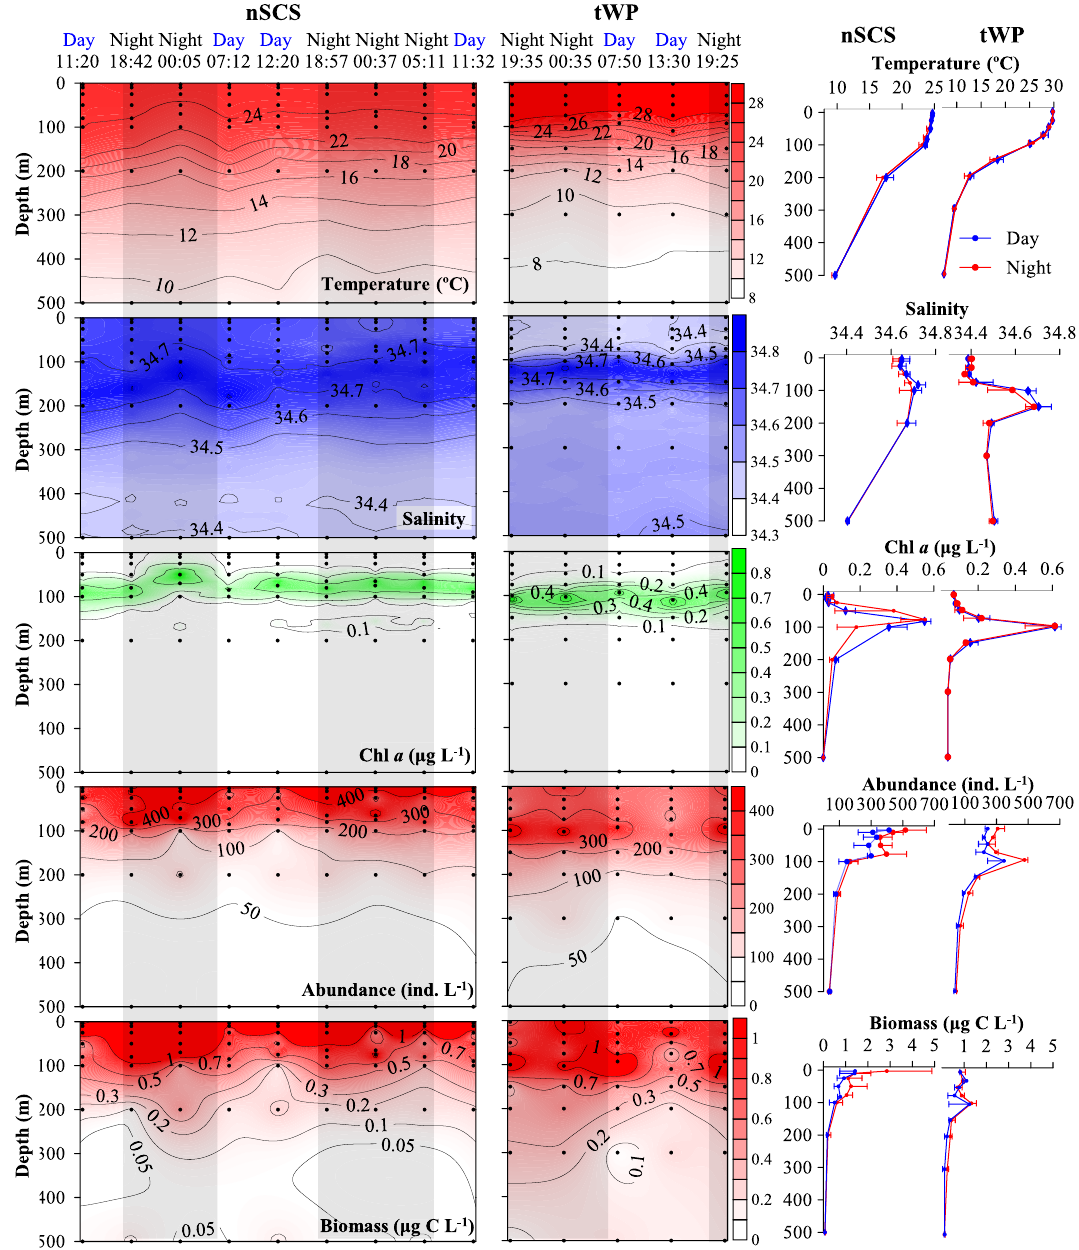
Figure 1. Temperature (T), salinity (S), Chlorophyll a (Chl a ), total ciliate abundance and biomass profiles from the surface to 500 m in the northern South China Sea (nSCS) and tropical Western Pacific (tWP). Black dots: sampling depths; black shadows: